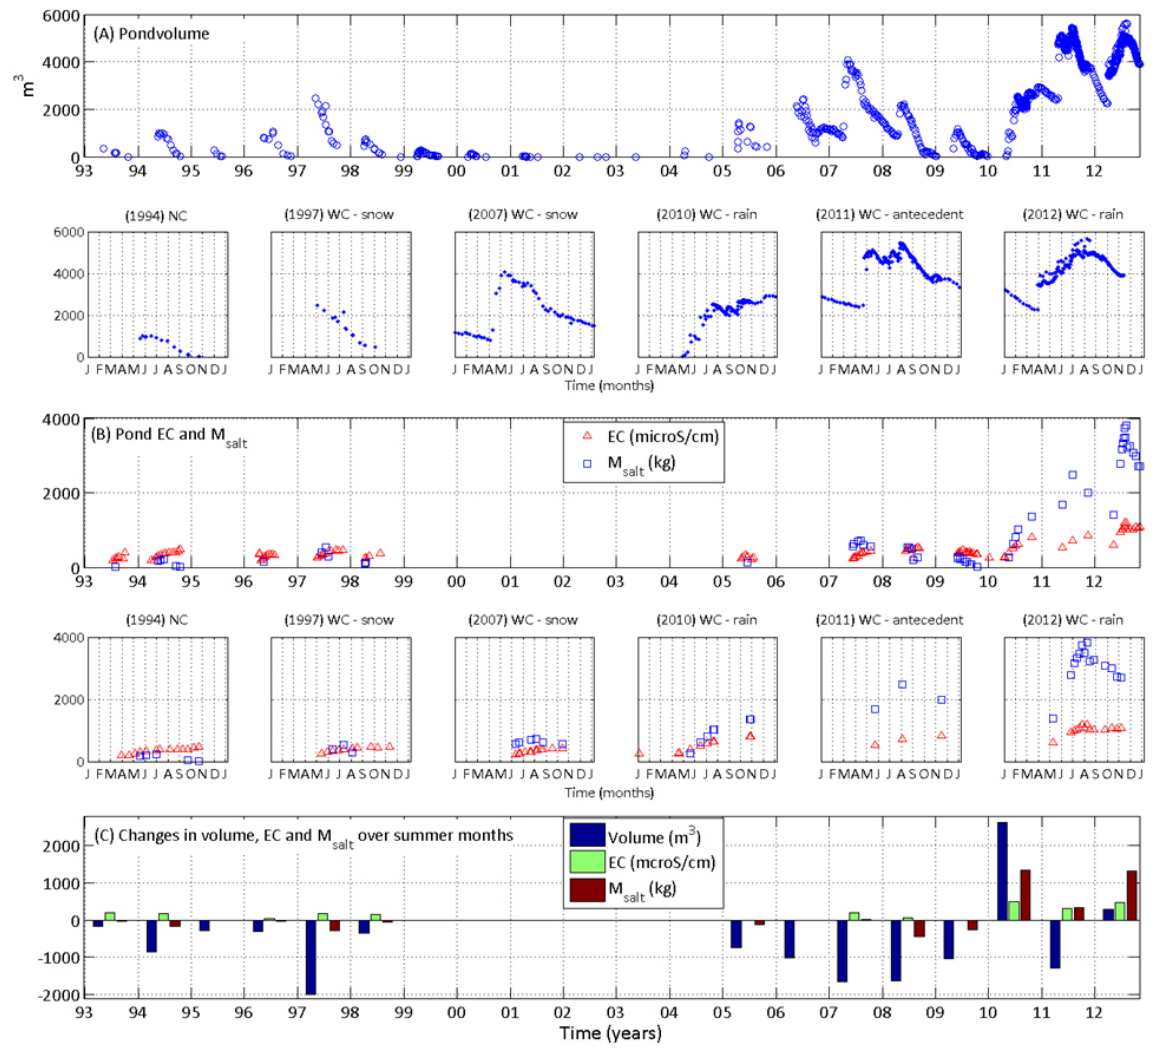
Fig. 5. (A) Pond 109 volume; (B) measured EC and calculated M salt ; and (C) summertime changes in volume, EC and M salt of the pond. Separated (lower) figures in (A) and (B) are zoomed for selected years with various climatic conditions, where NC and WC stand for normal and wet meteorological conditions,